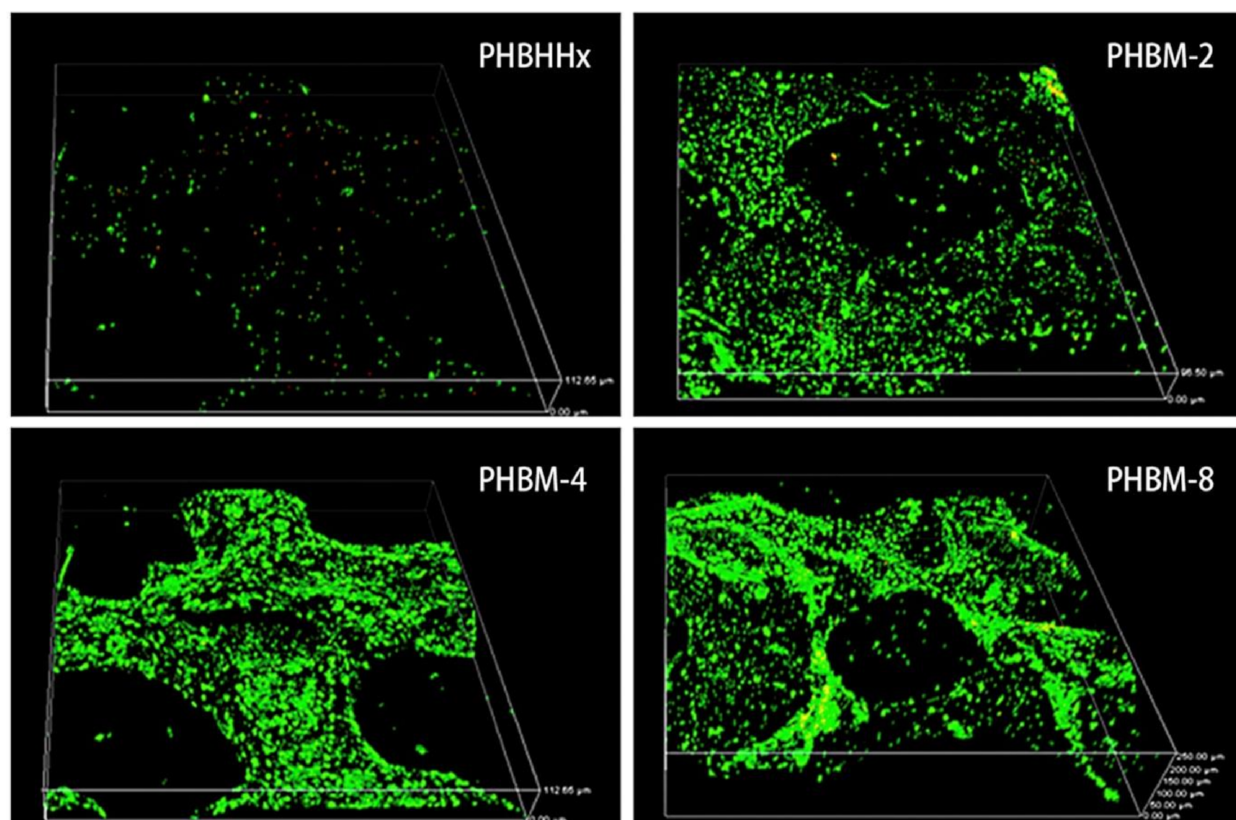
Figure 8. Live/dead staining of hMSCs cultured for 14 days. Live hMSCs were stained green, and dead cells were stained red. Reprinted from [98] with permission from